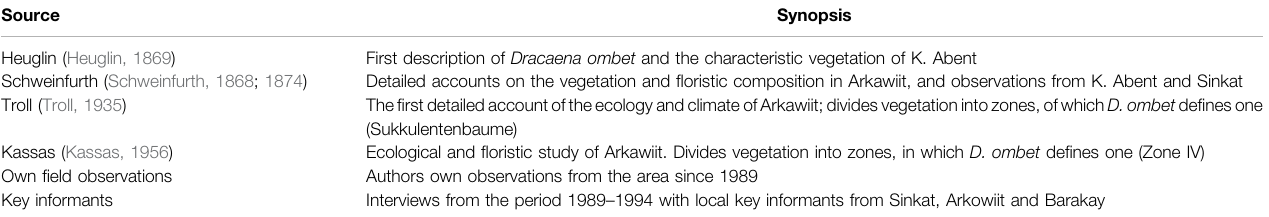
TABLE 2 | Overview of key sources used to de fi ne/describe pre-collapse system identity.